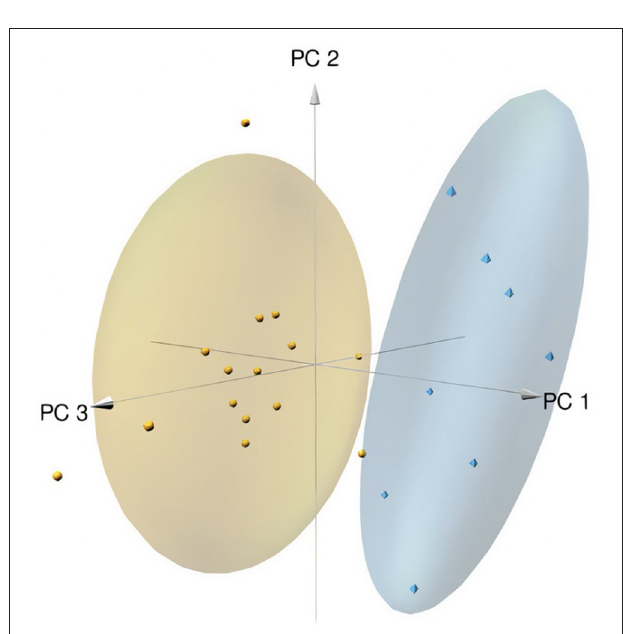
FIGURE 4 | Principal component analysis graphic. The space and data for controls are in yellow and the space and data for glaucoma individuals are in blue. The principal component (PC) 1, the PC2, and the PC3 explains the 62.61%, the 20.31%, and the 11.20% of the variance between groups, respectively. See Supplementary Tables S2, S3 for